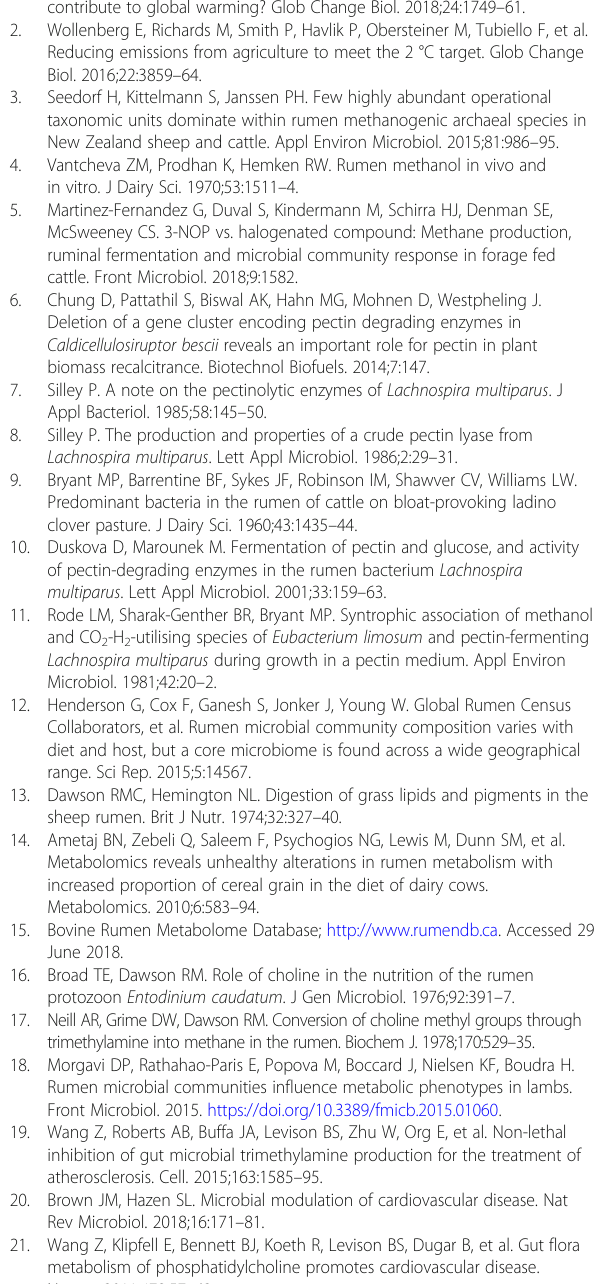
Additional file 3: Table S2. Pectin methyl esterase genes (Pfam01095) identified in the Hungate 1000 collection reference genome set Additional file 4: Table S3. Contigs and genome sizes of the three organisms identified from the MEC1 limited diversity metagenome. Additional file 5: Table S4. A Overview of samples analysed in this study. B Results of the mapping of the high/low sample reads to the identified rumen CutC and PME-containing genes from the Hungate1000 and the high/low combined